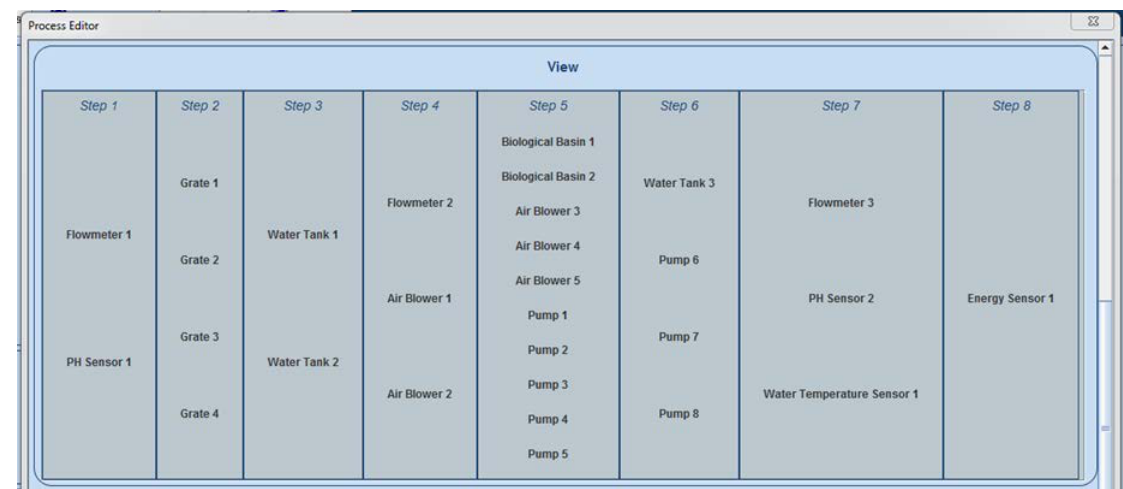
Figure 4. Editing an item in the Historian Process Editor.